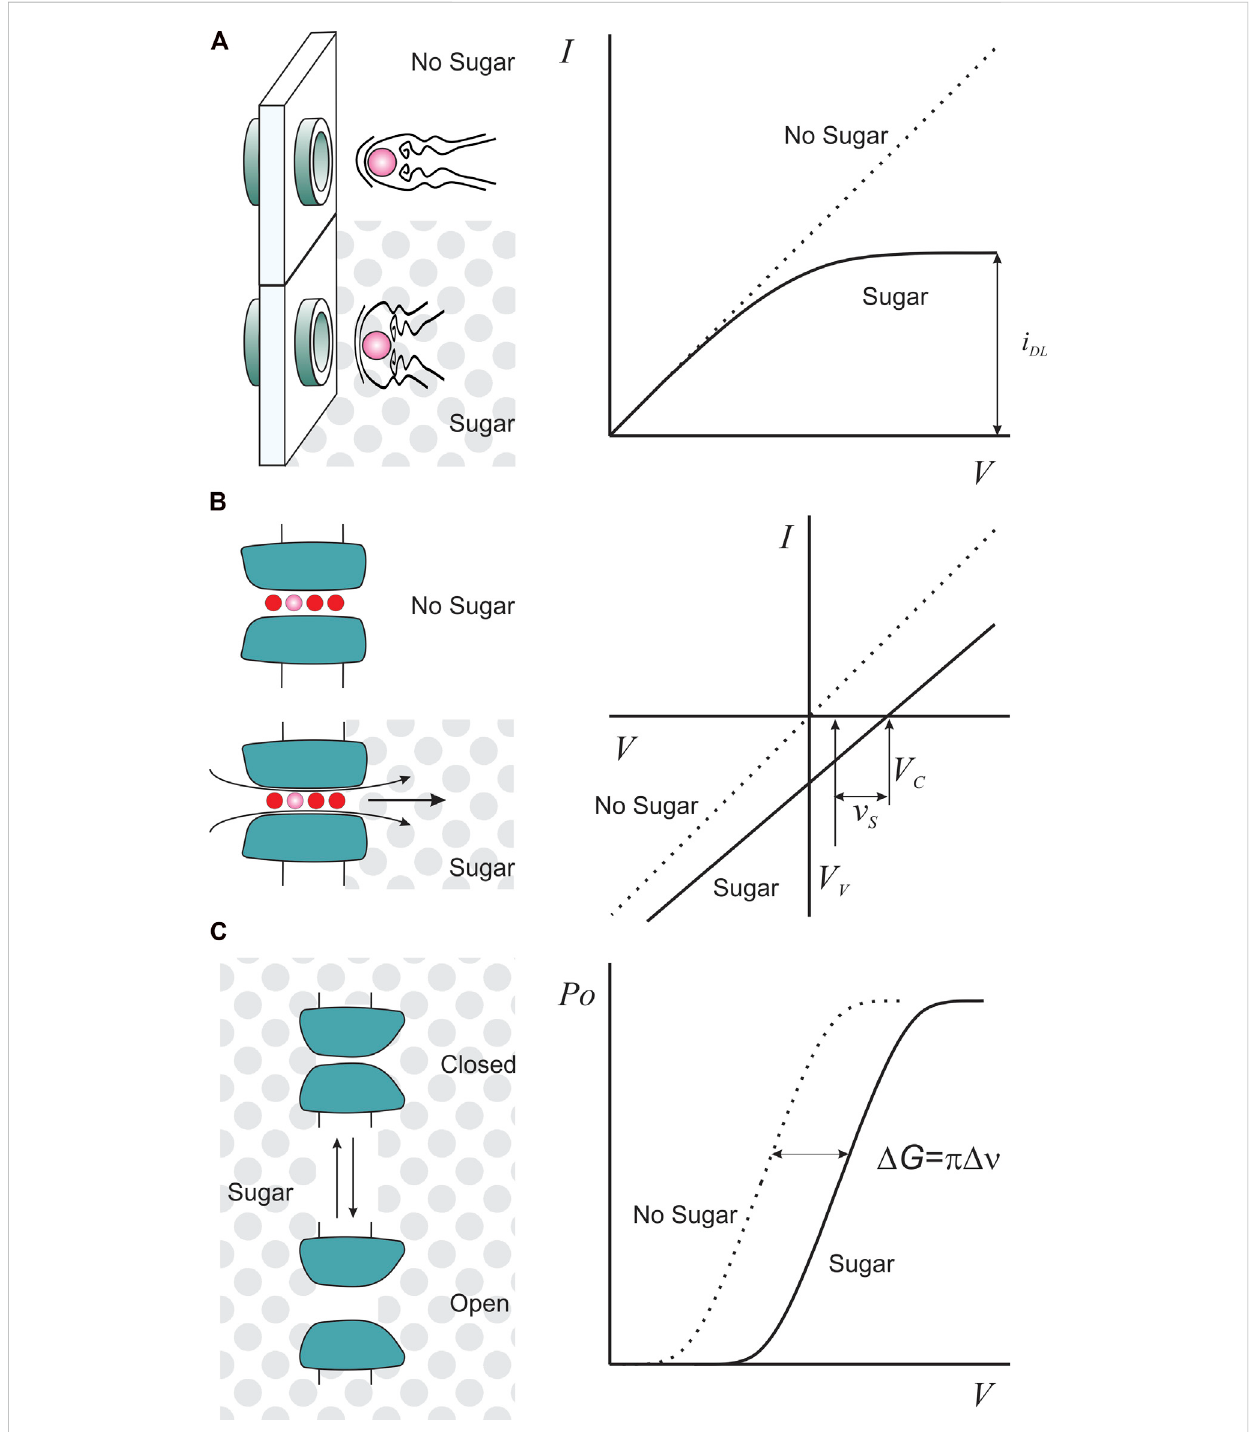
FIGURE 1 Sugars as functional tools for K-channels. (A) . Sugar (gray dots) as a viscosity agent reduces ion diffusional mobility such that it is possible to obtain saturating currents, i DL , at lower voltages (right). (B) . Unilateral sugar application, as an osmotic agent, produces a streaming potential with a magnitude proportional to the number of water molecules (red circles) escorting one permeant ion (pink). V C is the ion channel reversal potential in the presence of sugar, and V V is the valinomycin potential, measured to correct for activity changes in sugar solution (see main text). (C) . Sugar as an osmotic agent imposes an additional work ( Δ G) to the voltage-dependent channel opening (Po) if the conformational change exposes or hides an inaccessible sucrose volume ( Δν ), equating volumetric and electric